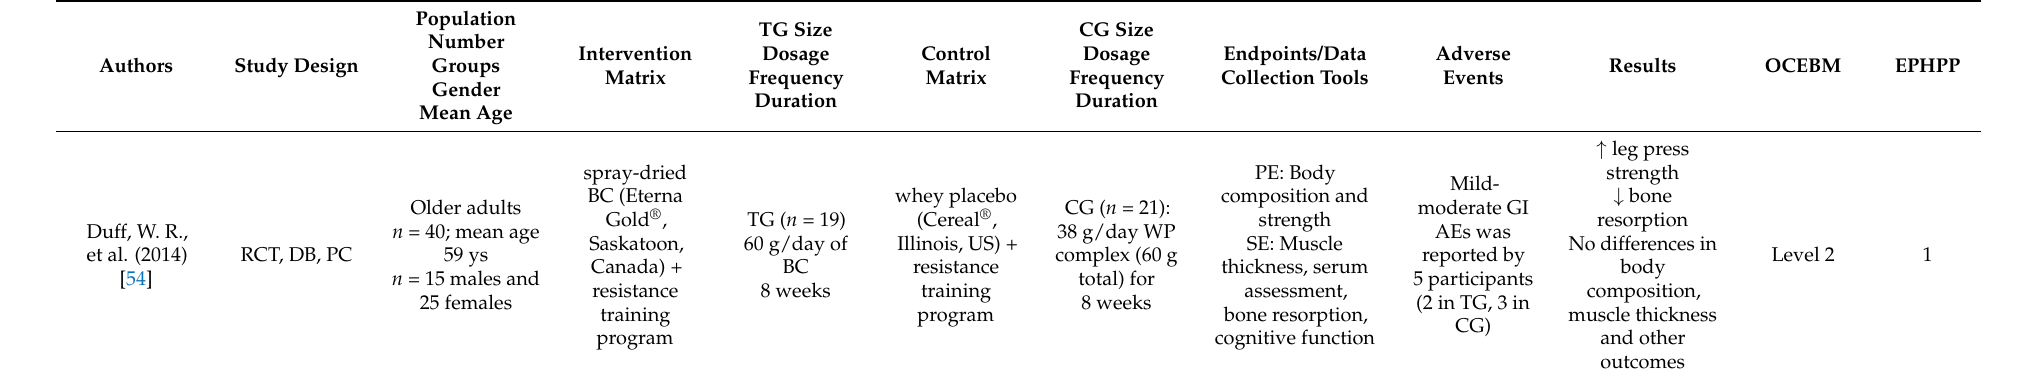
Table 5. BC as dietary supplement in healthy older adults.